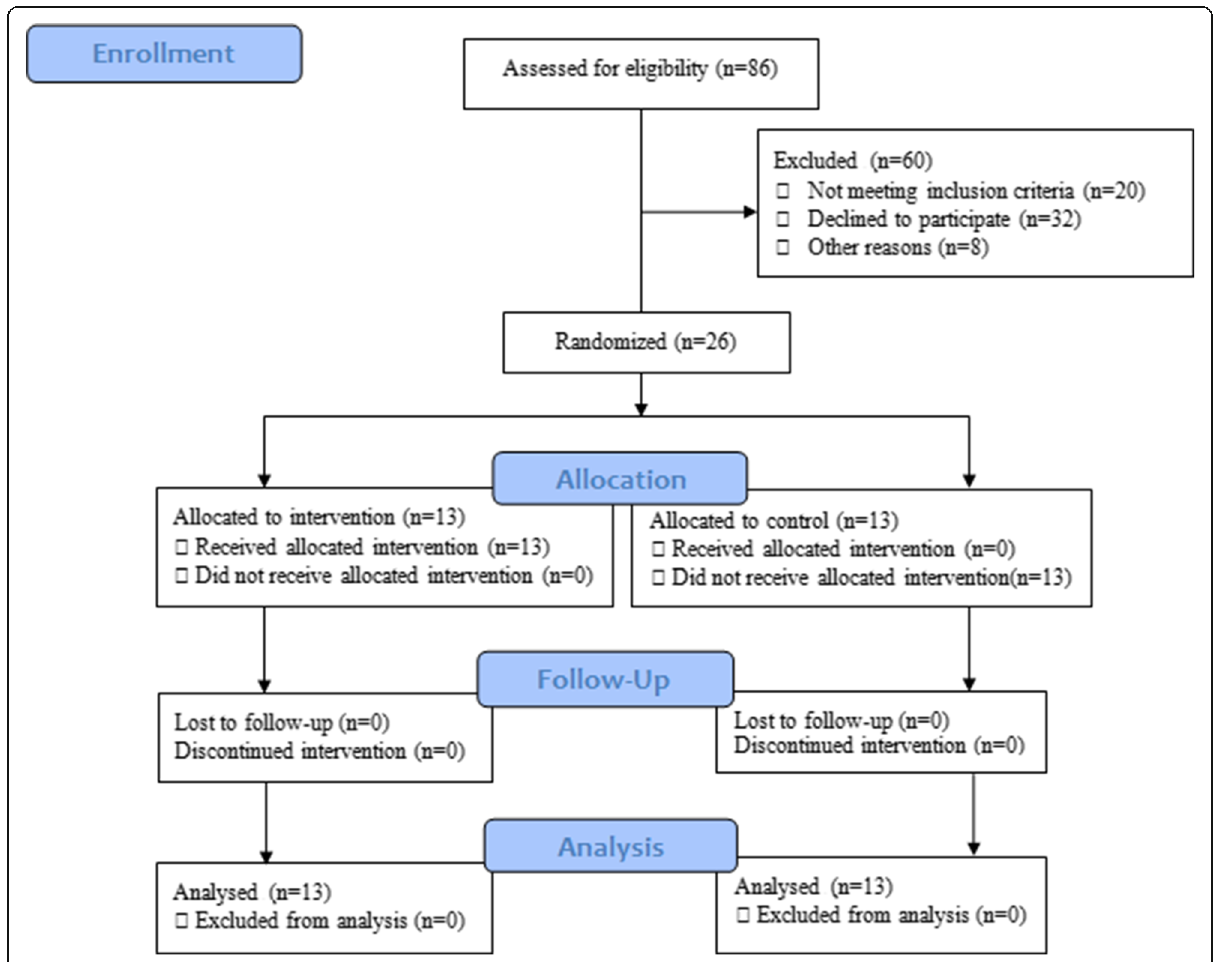
refractory period. These SOAs were taken from similar studies (Fagot & Pashler, 1992; Logan & Gordon, 2001; Soutschek, Taylor, & Schubert, 2016). To remove the structural interference between the limbs, the two blue and green keys on the right side of the participants were to be responded with their right hand, while the red and yellow keys on their left side were to be responded with their left hand. In each trial of the dual task, both hands were used to return to the random stimuli, using the left and right side for S1 and S2. No trial was made to use one hand for two responses. The order of appearance of colors for all stimuli was random (randomization was done from a computer-generated sequence), and two different colors were used in each trial. To eliminate the participants ’ sensitivity to color, all the possible se- quences of color were presented. The words were BLUE, GREEN, RED, and YELLOW present randomly in green, blue, red, and yellow. The 16 possible dual task situa- tions for congruent-congruent and 16 possible dual